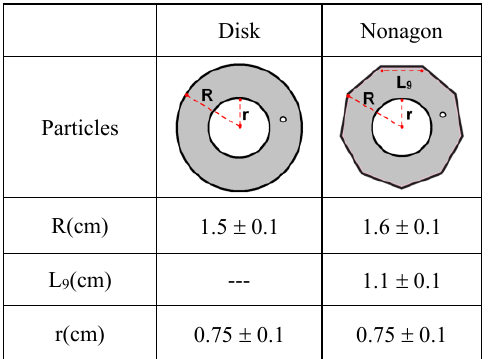
Table 1. Particles dimensions and main characteristics.